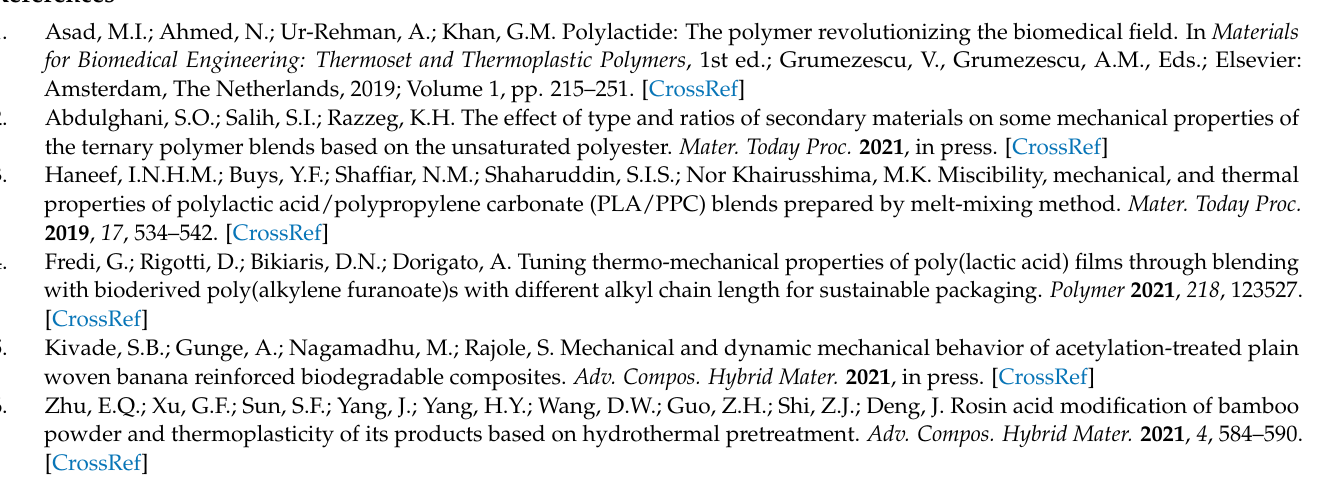
model 2k, Table S2: Factorial regression for polymer blends with elongation capacity, Figure S1. (a) Pareto chart of standardized effects for α = 0.05, (b) Normal chart, (c) Cube plot, and (d) Main effects of elongation, Table S3: Conditions for formulating polymer blends with elongation capacity, Table S4: Factorial regression for stiff polymer blends, Figure S2: (a) Pareto chart of standardized effects (response elastic modulus), (b) Normal chart, (c) Cube plot, and (d) Main effects for elastic modulus, Table S5: Conditions of high stiffness blends that are considered to continue with the elaboration of ternary blends, Table S6: Mechanical and physicochemical properties of neat PLA/5 min, neat PLA/15 min, binary and ternary blends, Figure S3. Loss modulus of ternary blends.